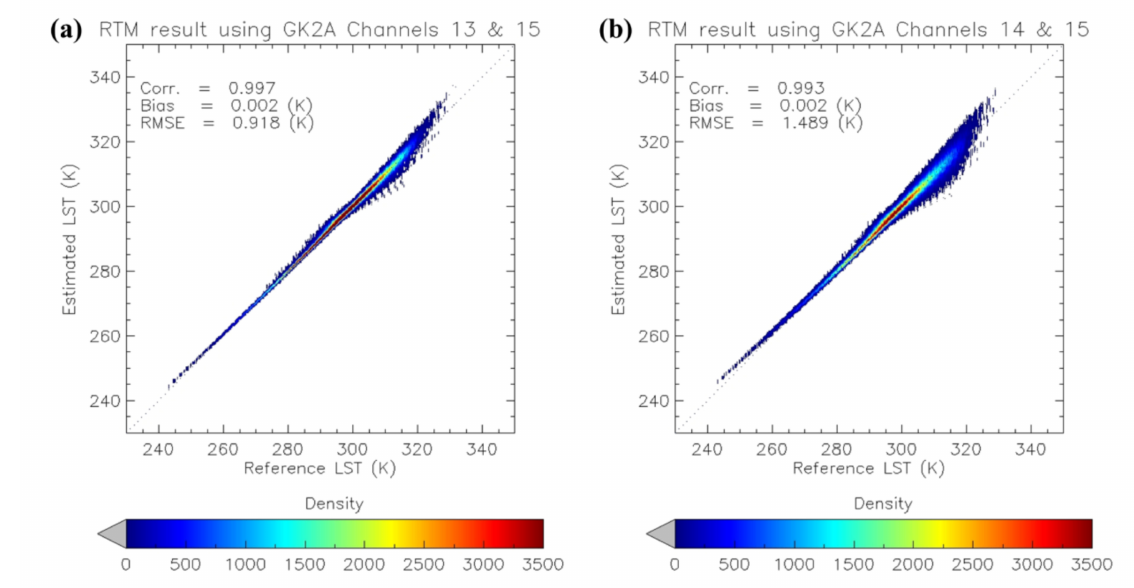
Figure 12. Scatter plots between reference LST and estimated LST from RTM simulation using two channels: ( a ) channels 13 and 15, and ( b ) channels 14 and 15.